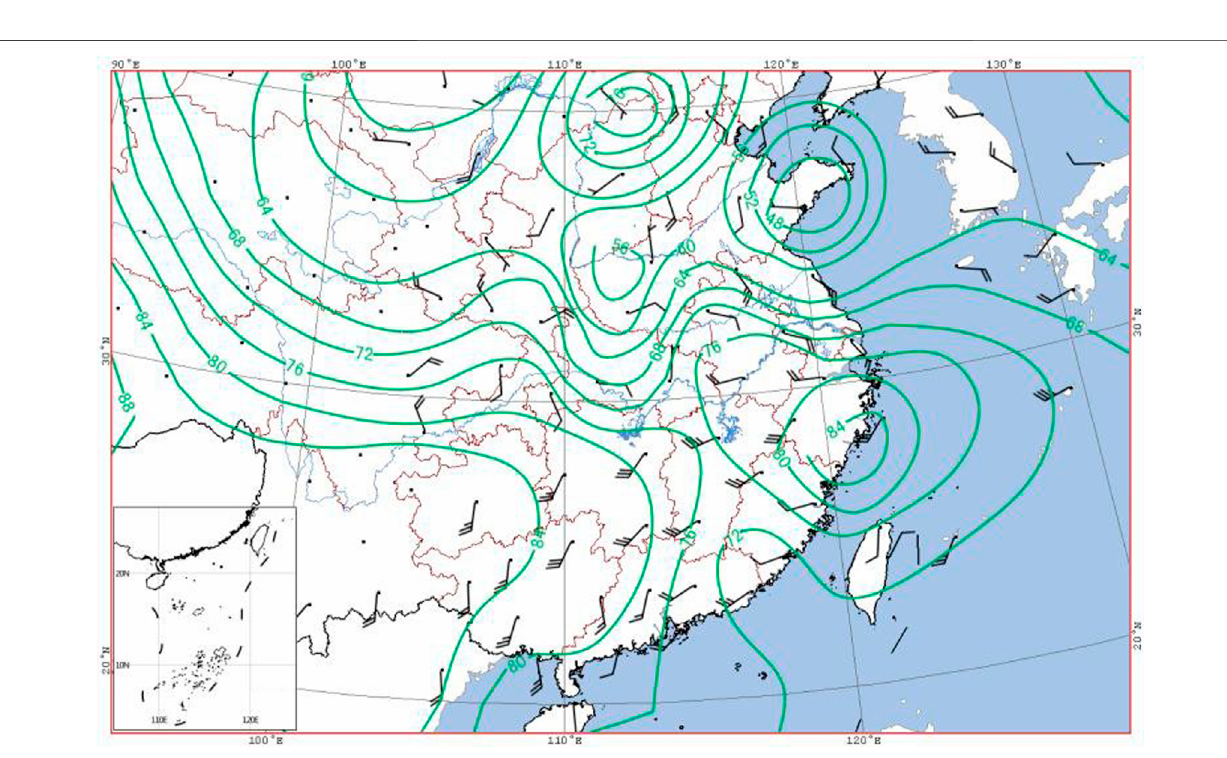
Frontiers in Earth Science |